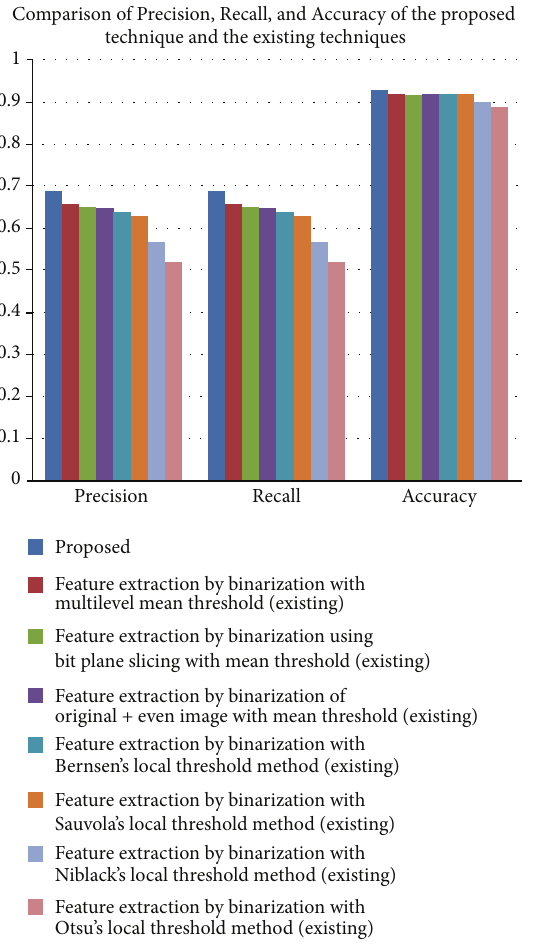
Figure 13: Comparison of Precision, Recall, and Accuracy of the proposed technique with respect to the existing